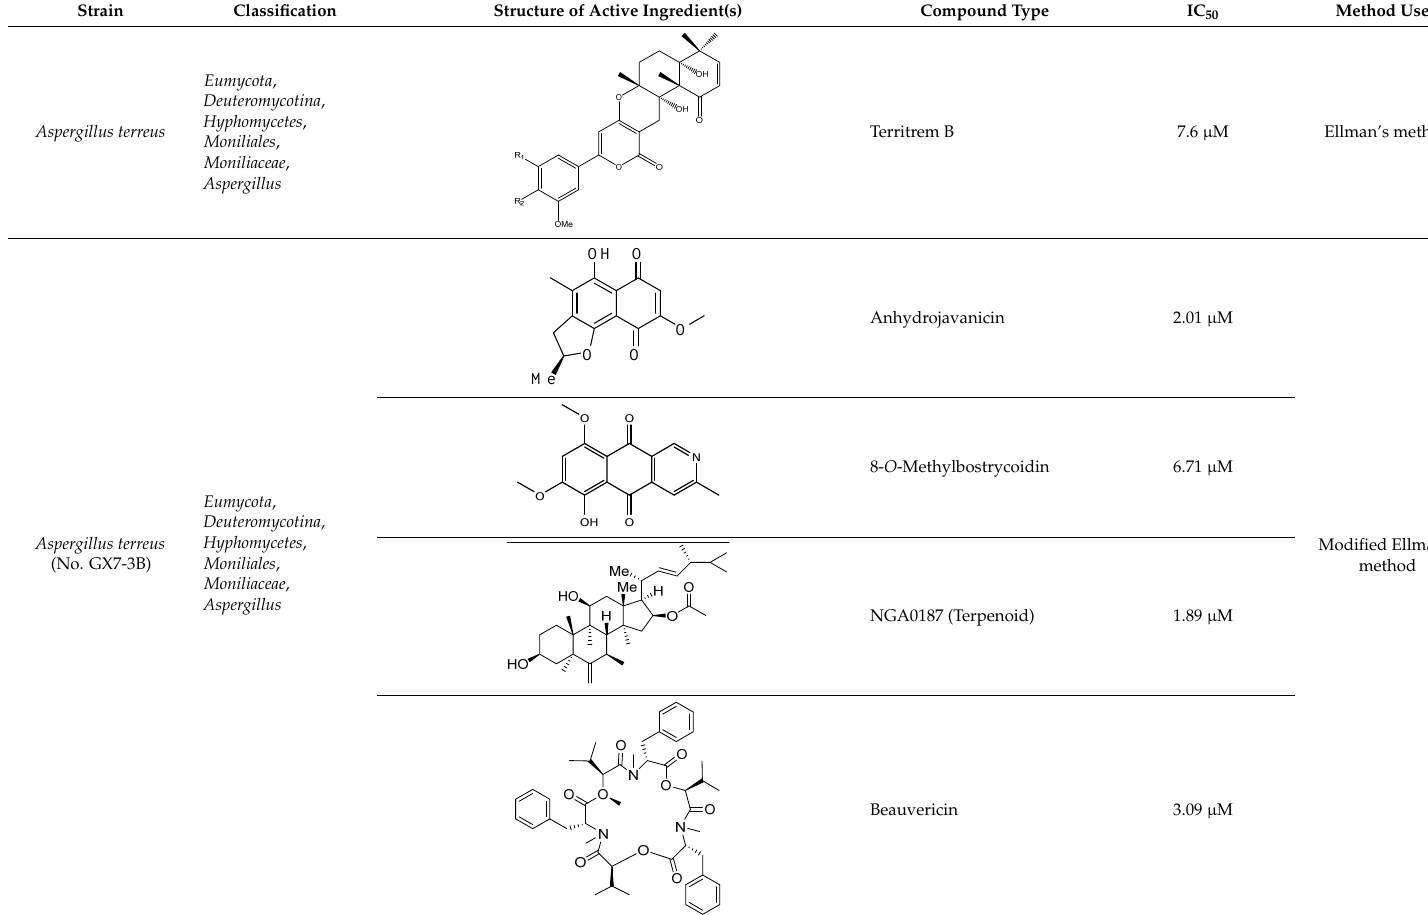
Table 2. Microbial producers of AChEIs.